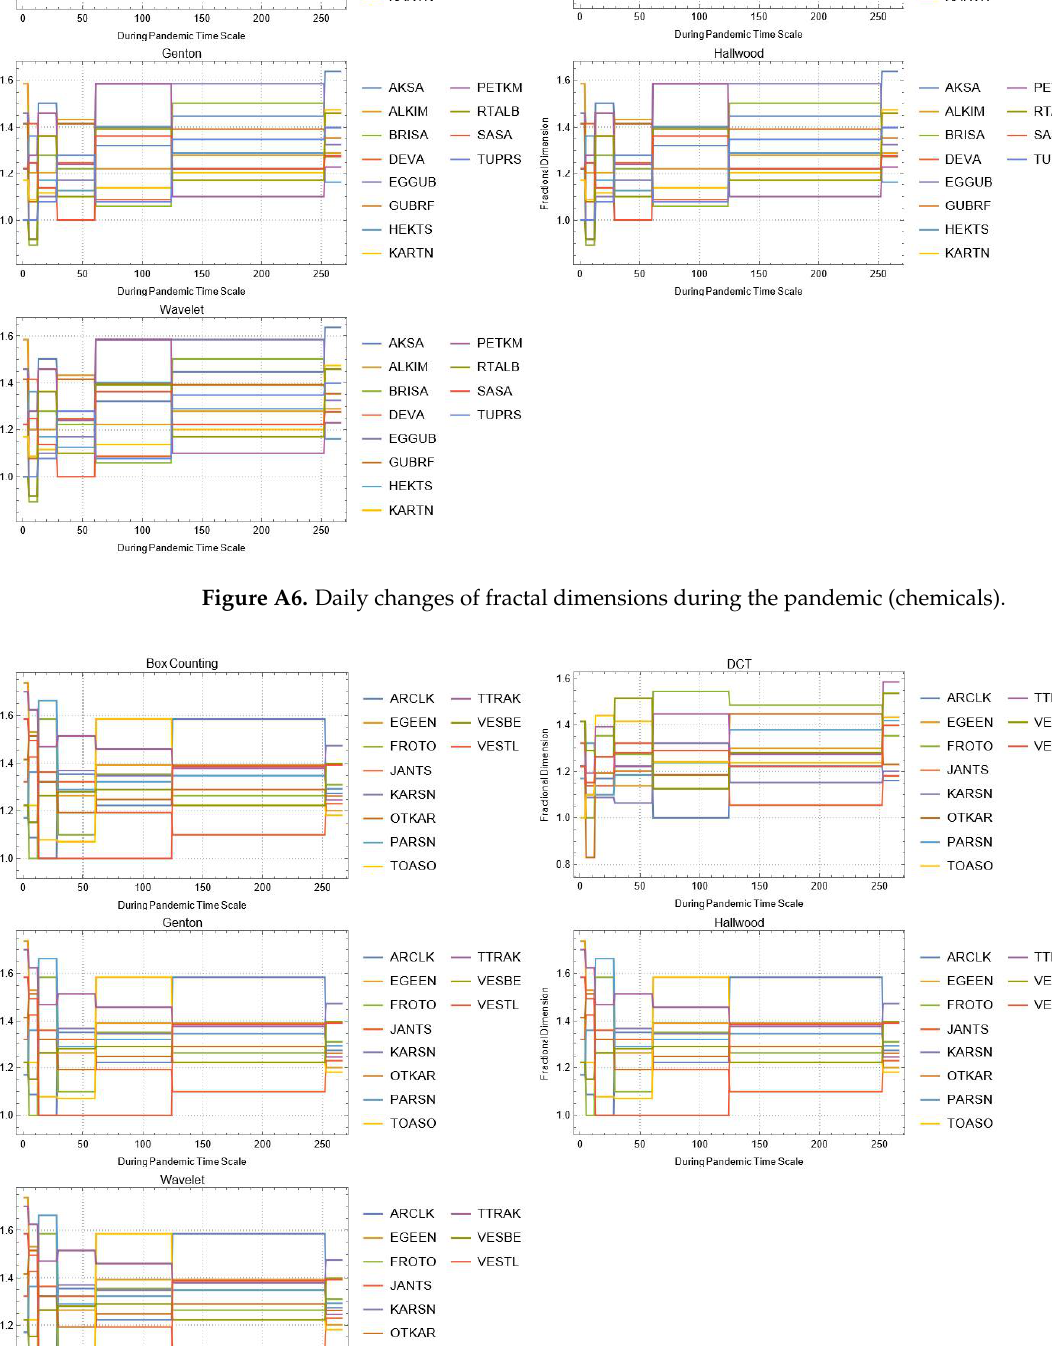
Figure A7. Daily changes of fractal dimensions during the pandemic (machineries).